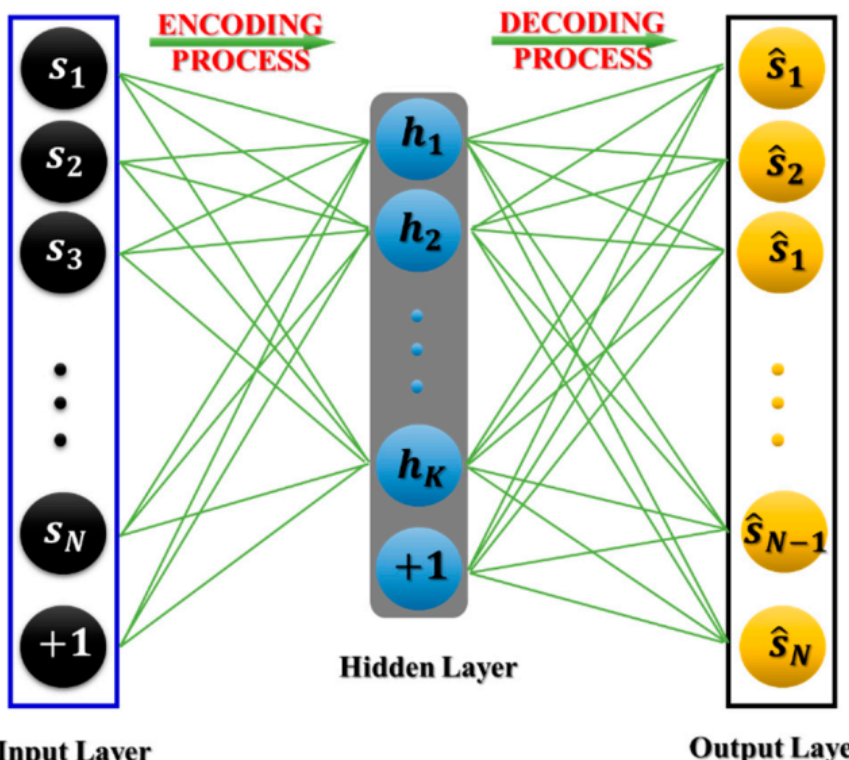
Figure 7. The diagram of the two learning processes of an